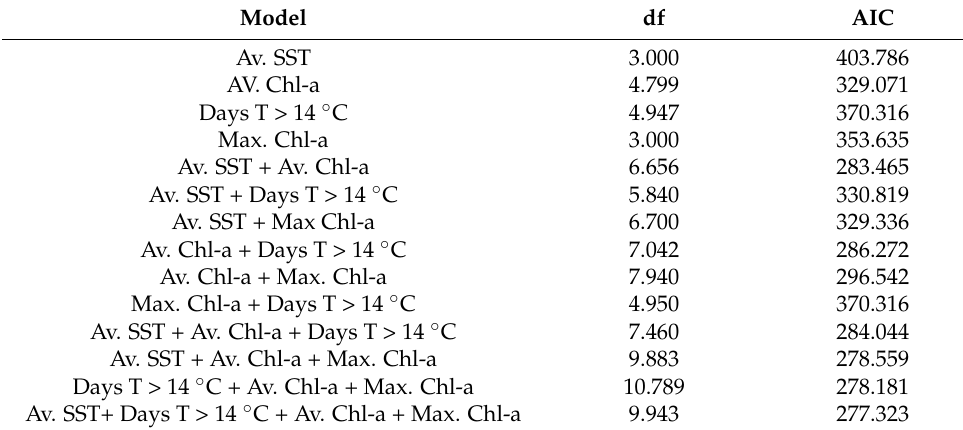
Table 5. Summary of Akaike Information Criteria (AIC) for the selection of optimal set of variables for inclusion in the model to explaining relative fecundity (RF) along the Portuguese coastline during 2014 and 2017 (grouped years). Short-term variables: average Sea Surface Temperature (Av. SST, ◦ C) and Average Chlorophyll-a concentration (Av. Chl-a, mg/m 3 ), both at last month before the sampling. Long-term variable: number of days with Sea Surface Temperature over 14 ◦ C (T > 14 ◦ C) during the 4 months before the sampling date and Average Chl-a concentration during 10 days around the peak of the spring transition (Max. Chl-a). Variables values used for the analysis were average for each location and year (d.f.: estimated degrees of freedom).